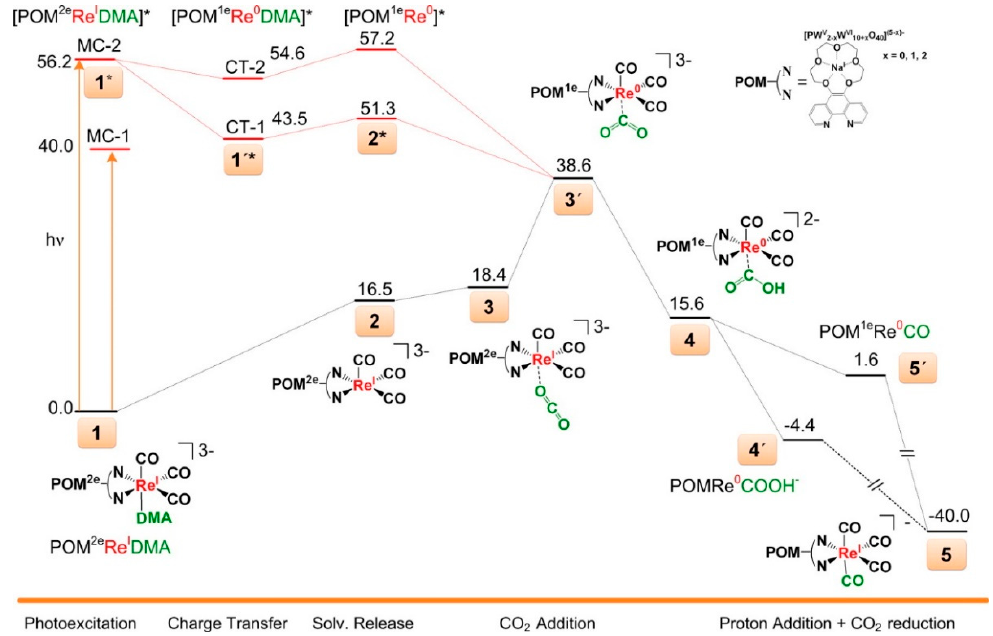
Figure 5. Potential energy (units in kcal mol − 1 ) surface for the reduction of CO 2 to CO catalyzed by POM-Re I complex. Reprinted with permission from [42]. Copyright © 2016 American Chemical Society.